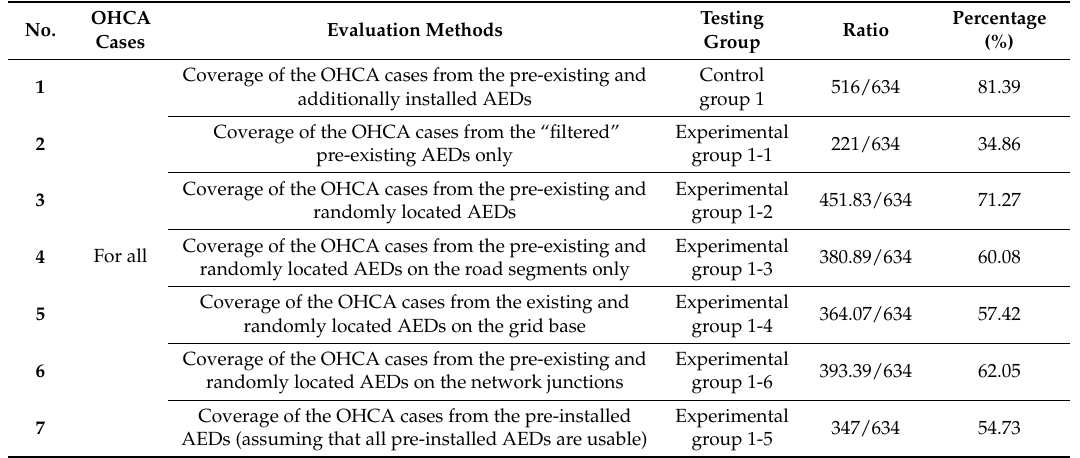
Table 2. Evaluation methods and results of all the OHCA cases.